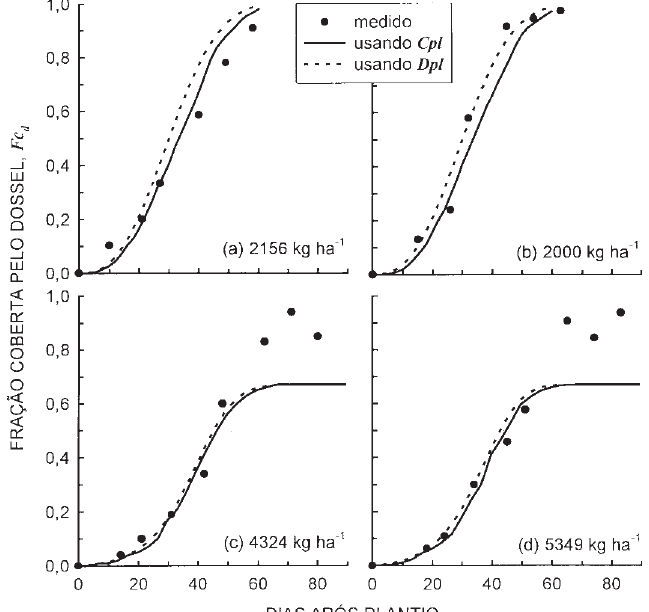
Figura 3. Comparação entre a fração do solo coberta pelo dossel medida e a calculada, usando dia proporcional após plantio ( Dpl ) ou calor acumulado proporcional após o plantio ( Cpl ), para duas glebas com as culturas do feijão (a e b) e do milho (c e d), com seus respectivos rendimentos, do município de Pato Branco, Paraná.